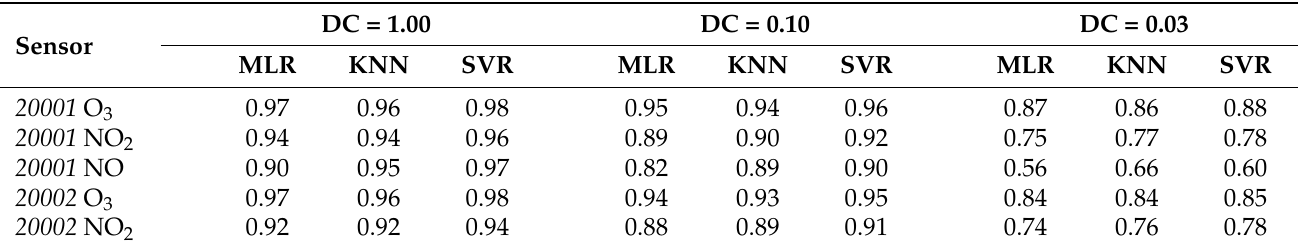
Table 5. Average CV R 2 obtained with the multiple linear regression, k-nearest neighbors, and support vector regression models for the different sensors and duty cycles, with T r =